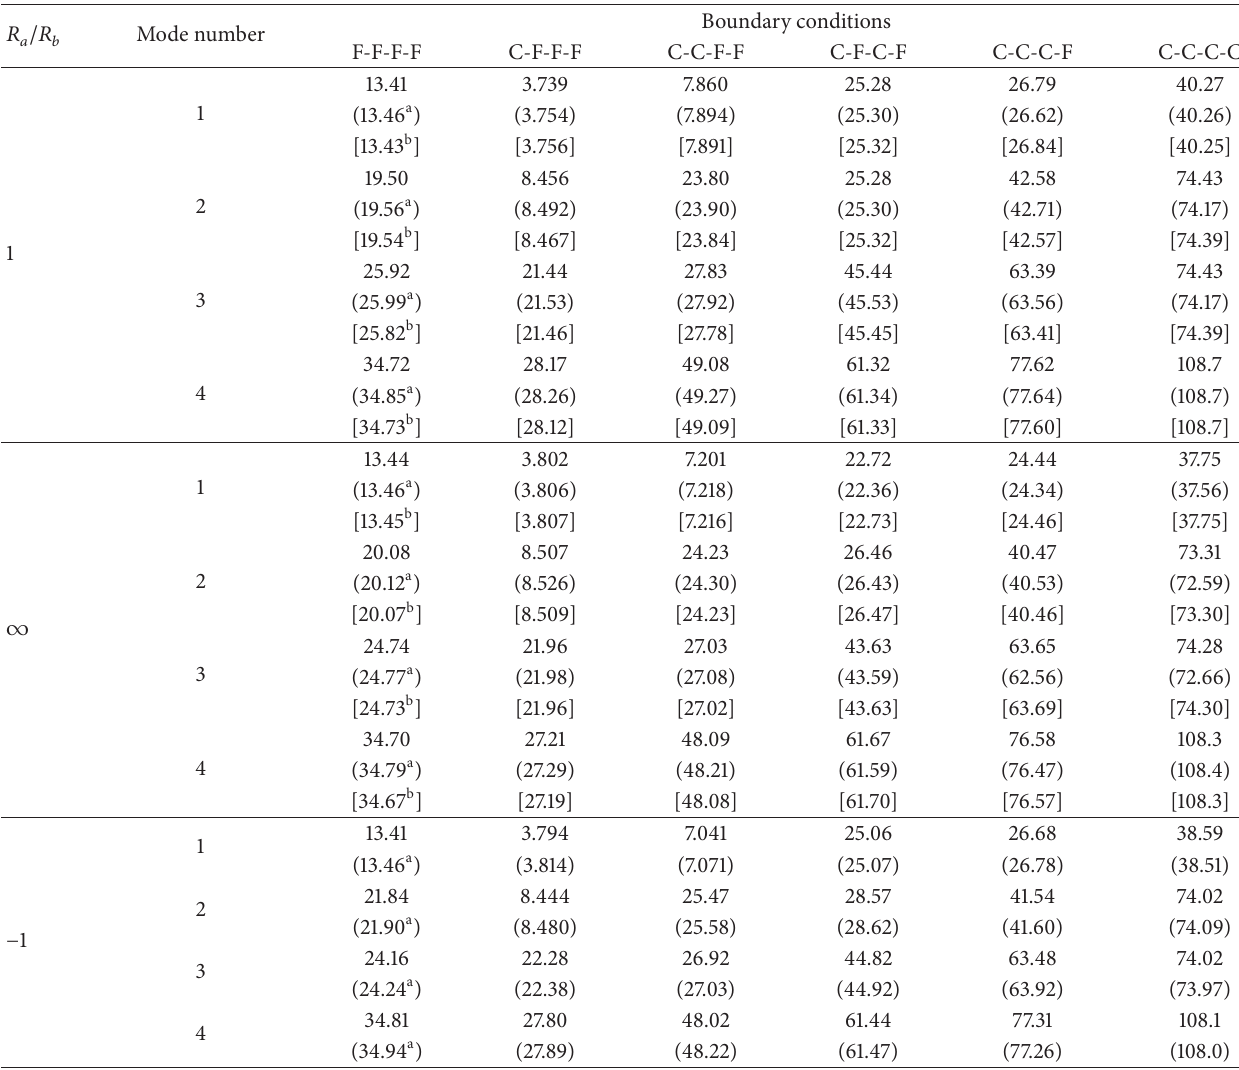
Table 3: Frequency parameters of shallow shells with different boundary conditions ( 𝑙 𝑎 /𝑅 𝑏 = 0.2 , 𝑙 𝑎 /𝑙 𝑏 = 1 , 𝑙 𝑎 /ℎ = 20 , and 𝜇 = 0.3 ). 𝑅 /𝑅 𝑎